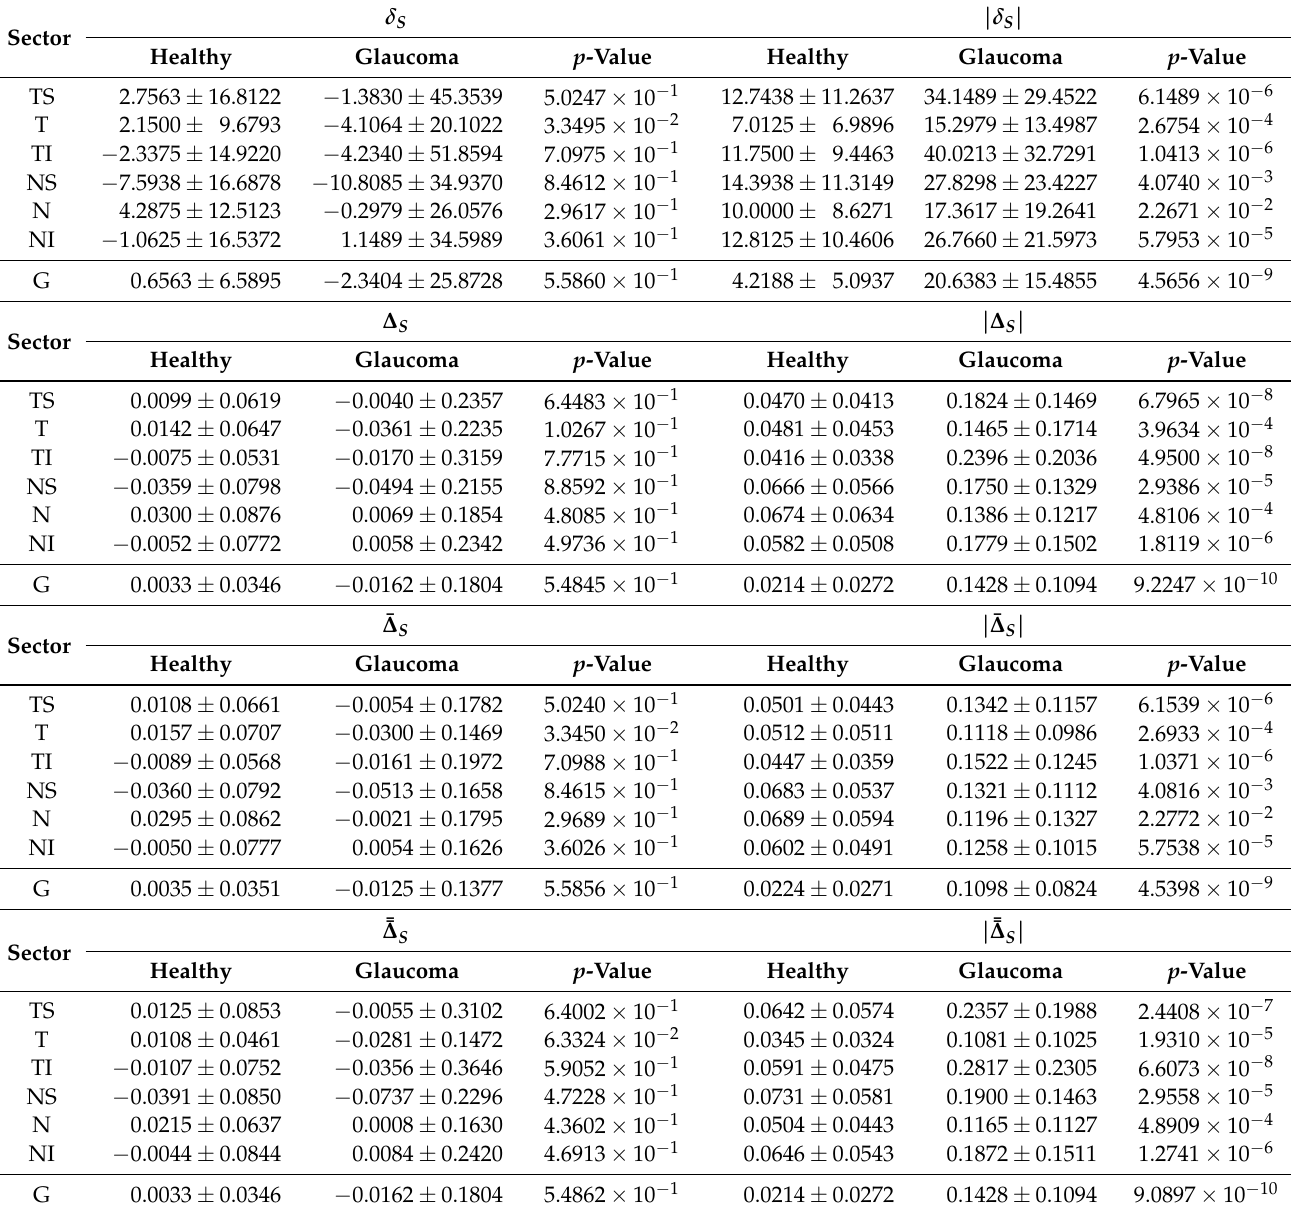
Table 4. Statistical characterization of the asymmetry metrics proposed for RNFL thickness. Mean value, standard deviation and p -value of each metric for the two subsets of healthy and glau- coma